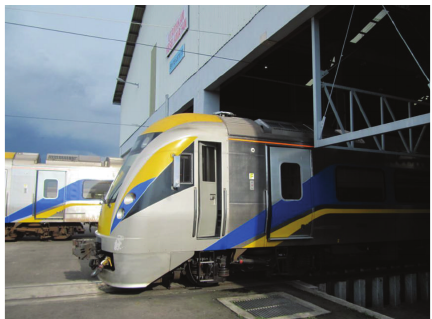
Figure 7: High speed terminal, electrified train system